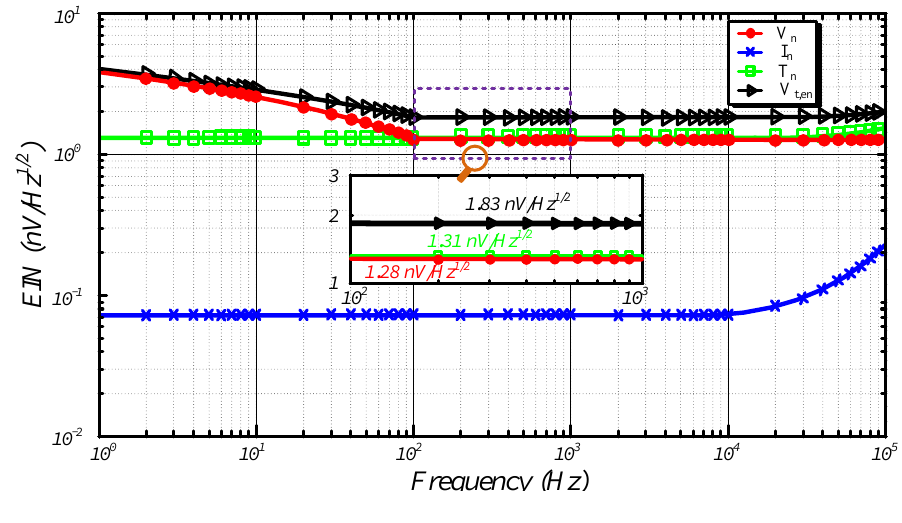
Figure 8. Noise source contribution map of